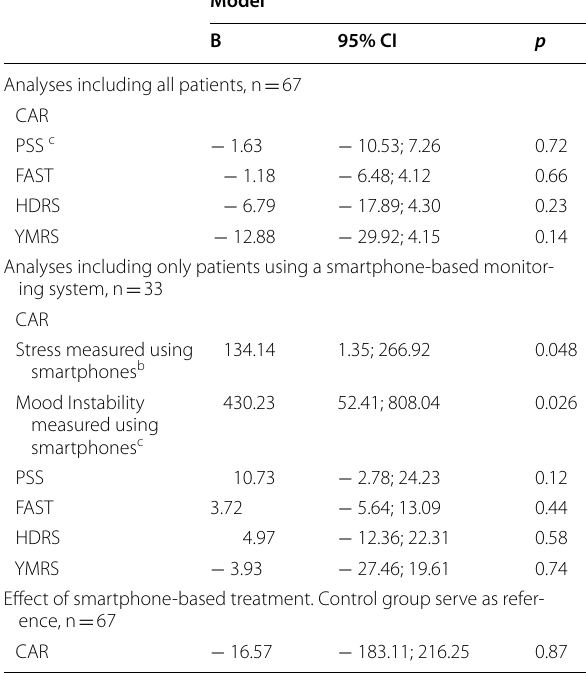
Table 3 Associations between cortisol